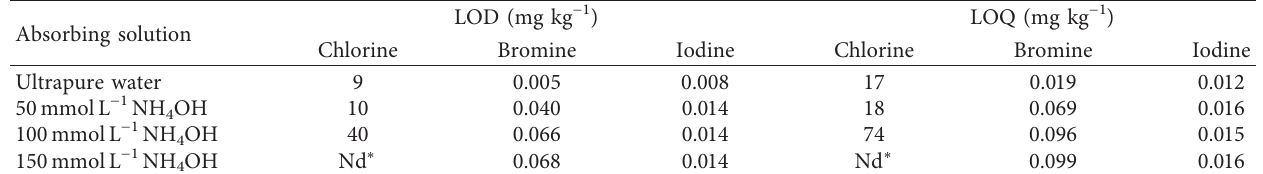
Figure 1: Chromatograms of the blanks using (a) ultrapure water, (b) 50mmolL − 1 NH solution. Table 2: Limits of detection and quantification for chlorine by IC and for bromine and iodine by ICP-MS, using different absorbing solutions for sample preparation of mushrooms (500 mg) by